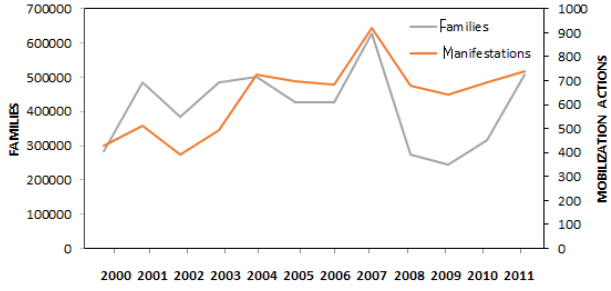
Figure 2. Number of demonstrations and participants, 2000–2011. Source: Based on [27].